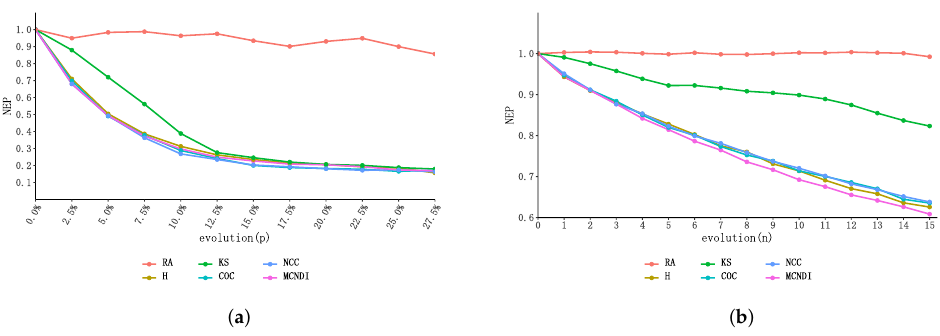
Figure 7. This figure shows the topological distribution of the real network in our network experiment. ( a ) Simulation comparison chart of the USAir97 network subjected to deliberate attacks with different indicators, where the horizontal axis represents the ratio of failed nodes to the total number of nodes, and the vertical axis is the network efficiency ratio. ( b ) Simulation comparison chart of the technology routes networks subjected to deliberate attacks with different indicators, where the horizontal axis represents the evolutionary stage (every five nodes are a basic evolution stage) and the vertical axis is the network efficiency